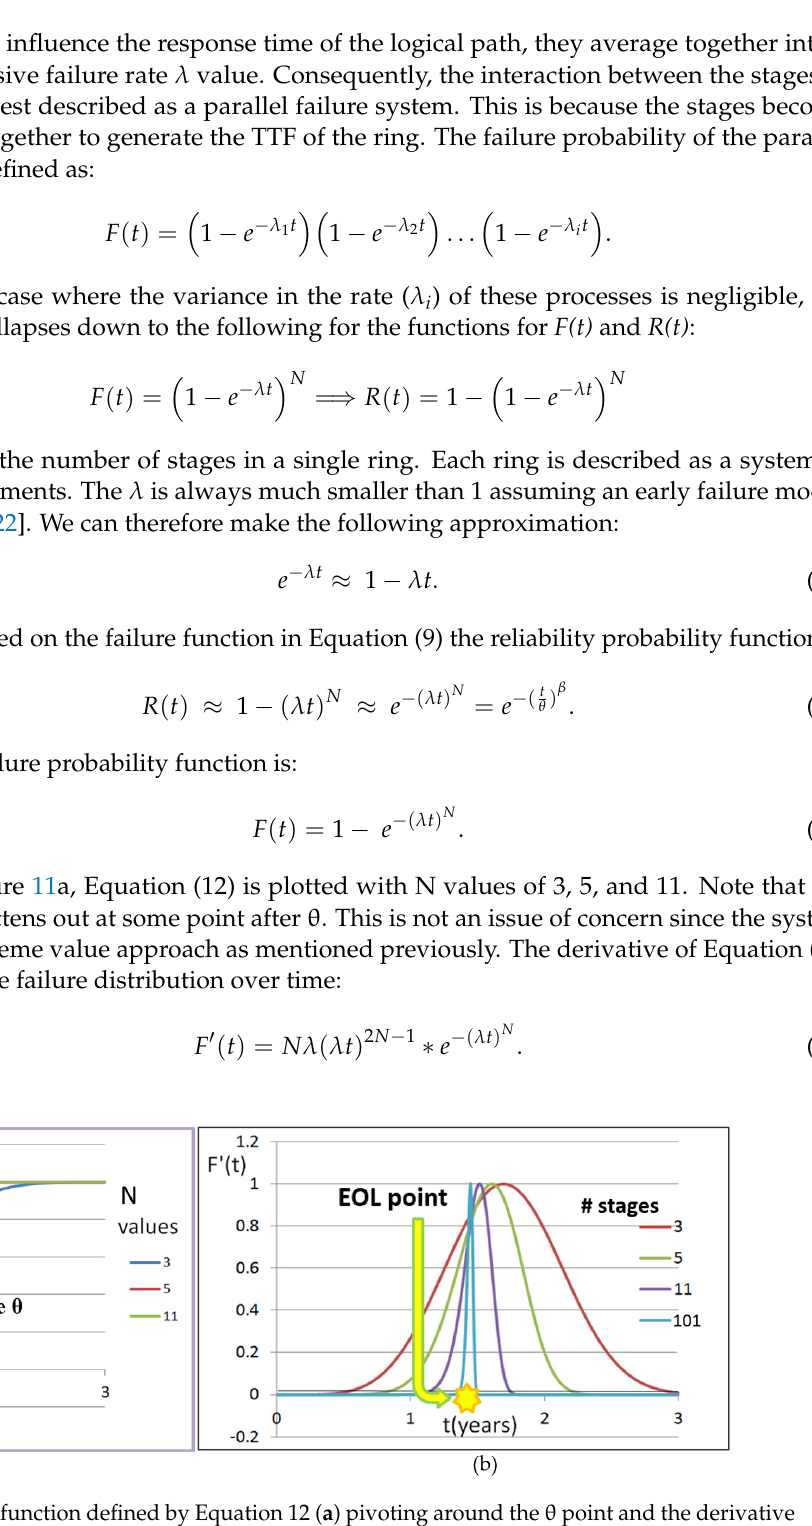
Figure 11. Plots of the failure distribution function defined by Equation 12 ( a ) pivoting around the θ point and the derivative of the failure distribution function defined by Equation 13 ( b ) revealing the end-of-life (EOL)